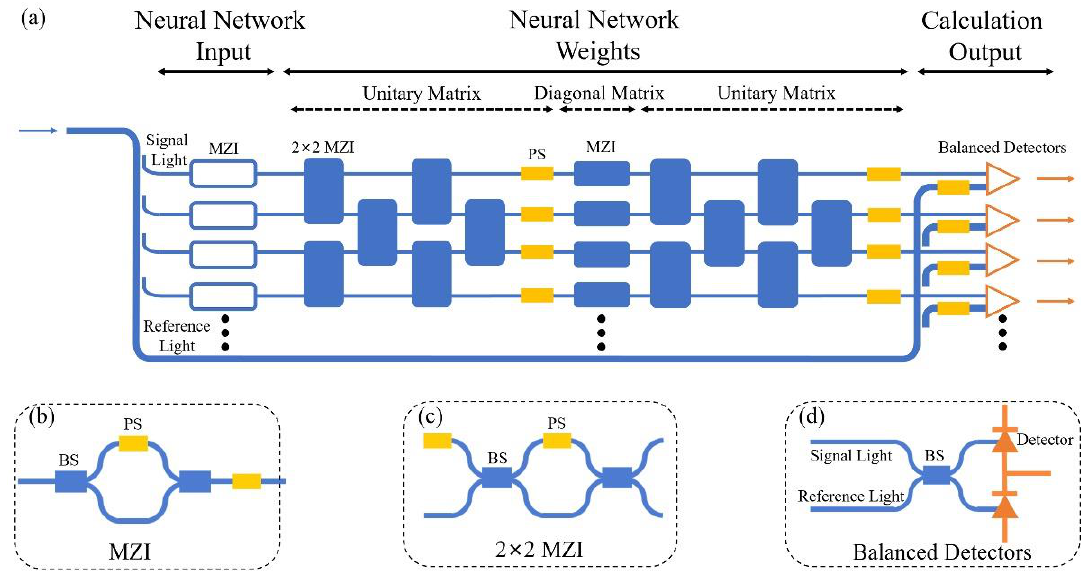
Figure 1. ( a ) The photonic complex-valued neural network (PCNN) chip. ( b ) MZI, ( c ) 2 × 2 MZI and ( d ) balanced detectors are basic units of neural network input part, neural network weights part and calculation output part. MZI: Mach–Zehnder interferometer; PS: phase shifter; BS: beam splitter. Table 1. Variables of the PCNN chip. Part of PCNN Chip Variable Description